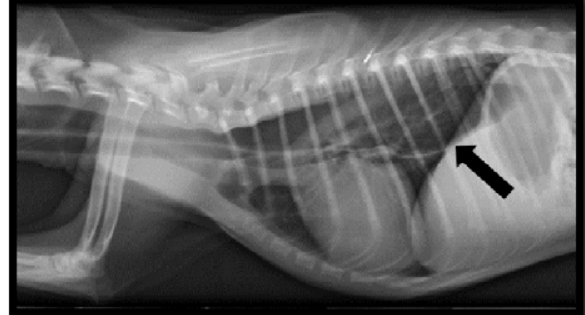
Figure 2: Thoracic radiograph demonstrating megaoesophagus (Source: Radiographs taken at Onderstepoort Veterinary Academic Hospital)